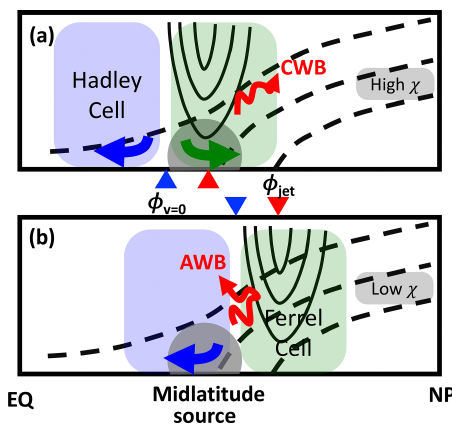
Figure 6. Similar to Fig. 3, but for the correlation between Arctic χ CO50 and latitudinal location of the NH midlatitude jet φ jet over the Pacific Ocean (135 ◦ E–135 ◦ W) (Barnes and Polvani, 2013). Note that the sequence of displayed seasons switches with JJA in (a) and DJF in (b) .